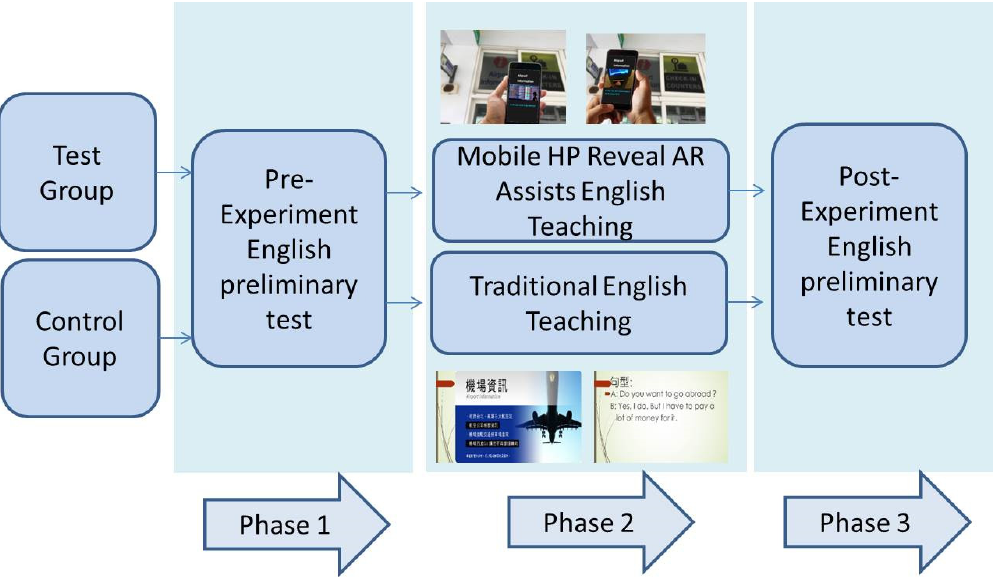
Figure 6. The three stages (phases) of our experiment.